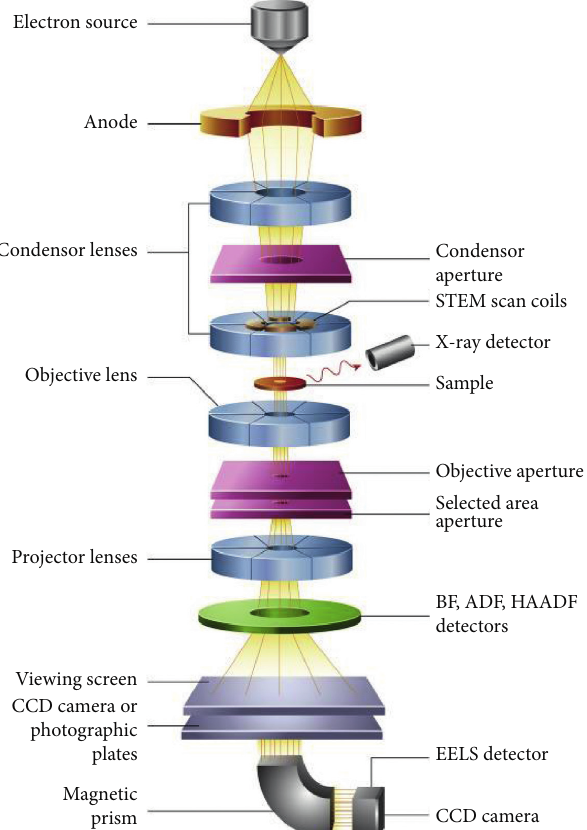
Figure 16: Basic components of TEM [125].